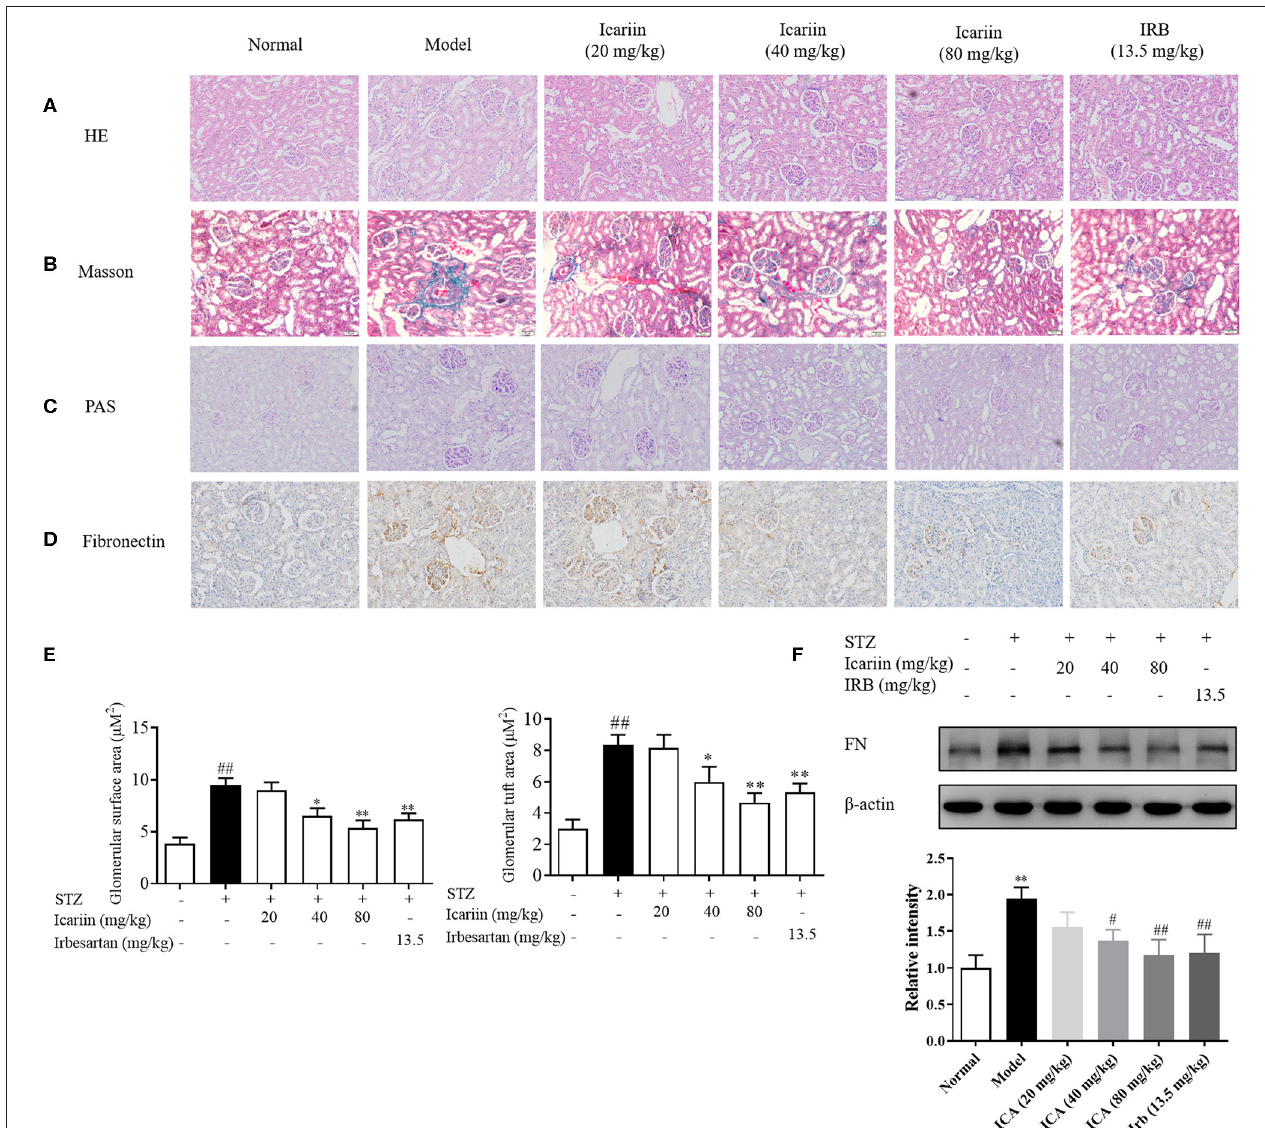
FIGURE 5 | Effect of icariin on the generation of ECM in STZ-induced diabetic rat. (A) The histopathology analysis of glomeruli using HE staining (200 × ). (B) The histopathology analysis of glomeruli using PAS staining (200 × ). (C) The histopathology analysis of glomeruli using Masson staining (200 × ). (D) Expression of FN in glomeruli through immunohistochemical (200 × ). (E) Glomerular surface area and glomerular tuft area were quantified using 30 glomeruli per mouse using ImageJ Software. (F) Expression of FN protein expression by western blot. Data are expressed as mean ± SD. * p < 0.05, ** p < 0.01, compared with the normal control group; # p < 0.05, ## p < 0.01, compared with the Model group.